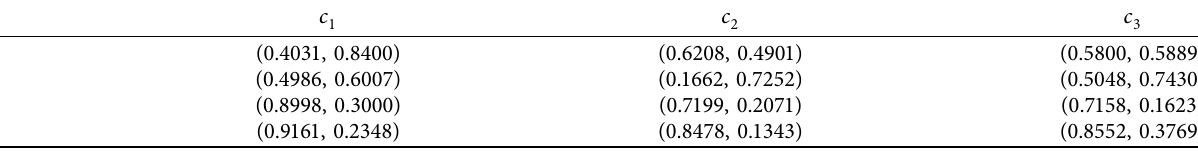
Table 3: Air quality data by expert E